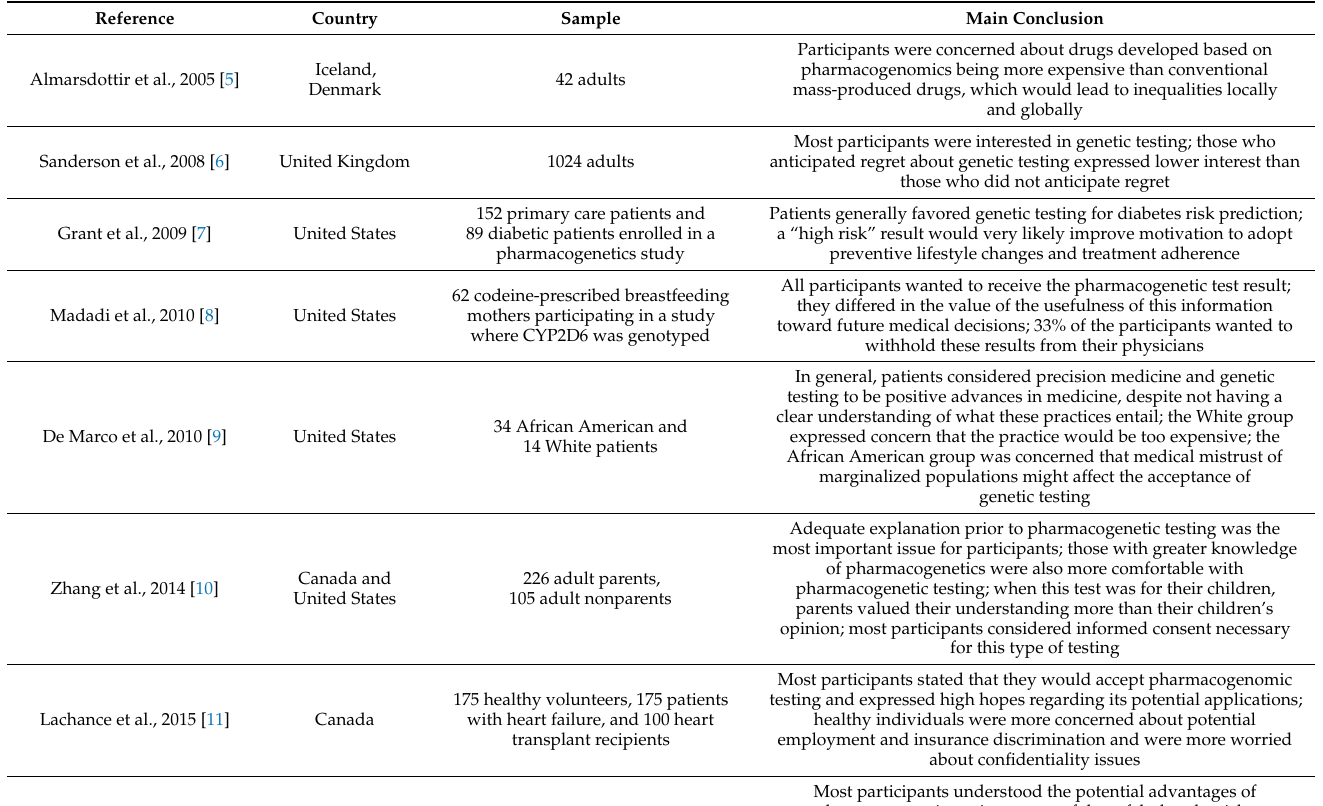
Table 2. Relevant works published to date addressing patients’ perceptions on pharmacogenetic